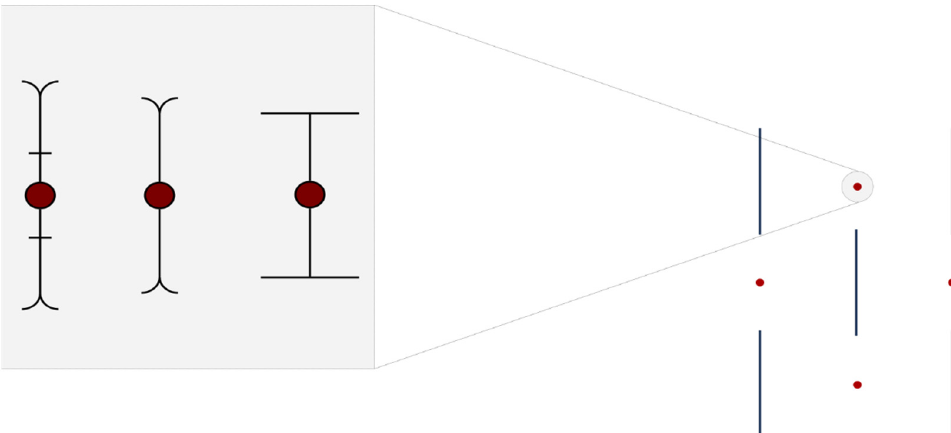
Figure 6. The cross-section view of three distinct profiles of barbed discharge electrodes with sharp tips to aid with inducing higher current values.